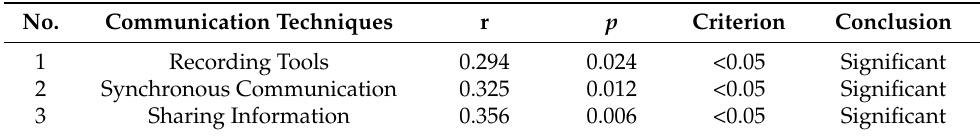
Table 3. Analysis results of zero-order correlation of variables of recording tools, synchronous communication, and sharing information with the quality of the teacher’s teaching process.